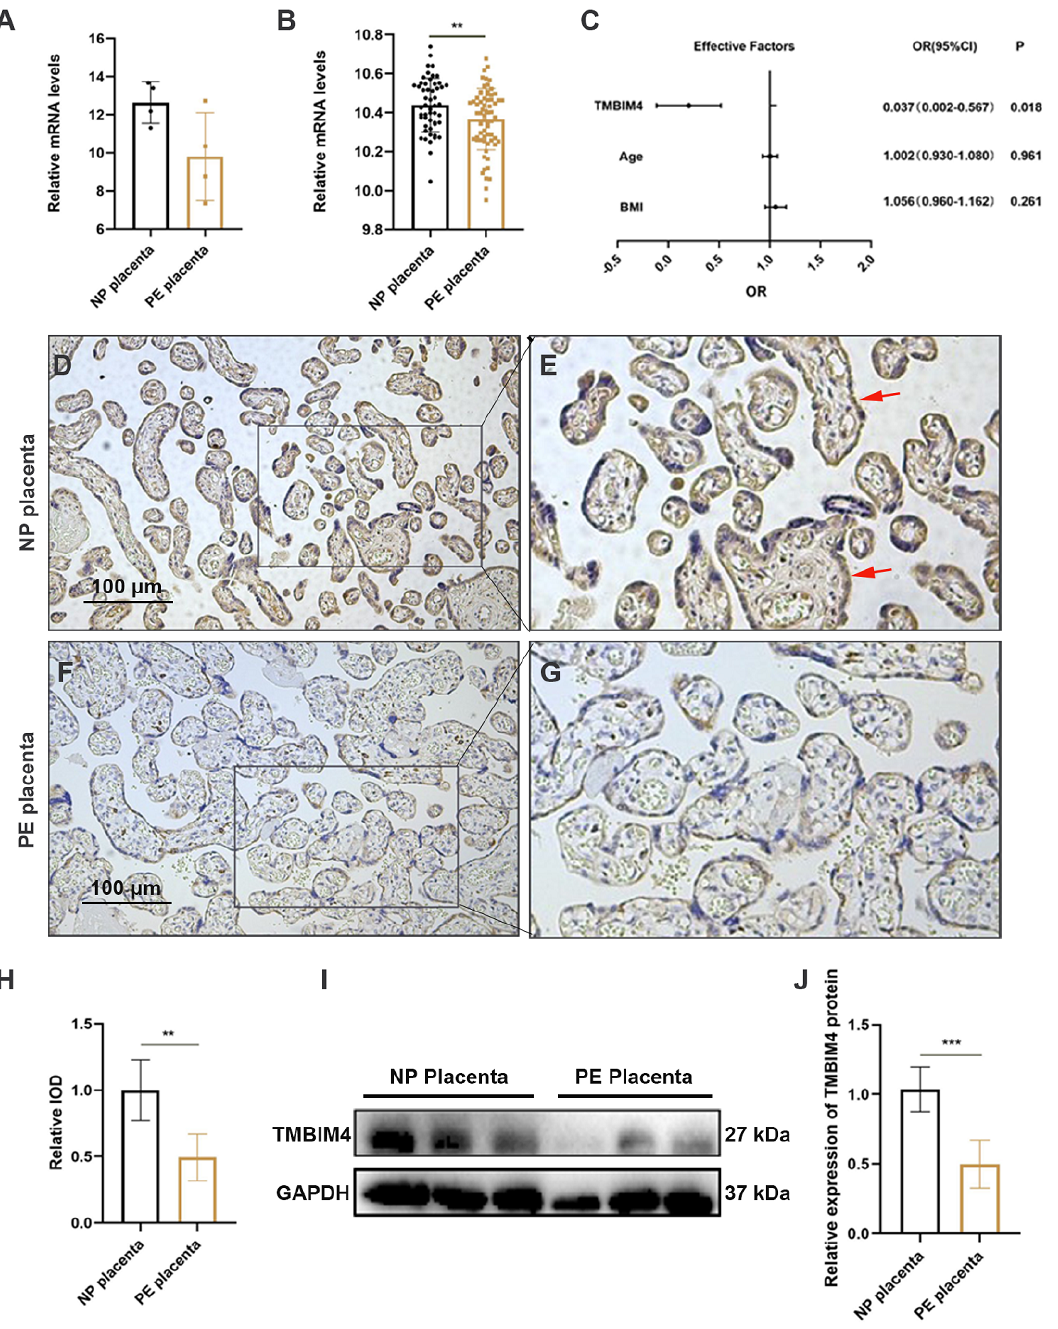
Figure 2. Decreased TMBIM4 levels in PE placentas. ( A ) Column plots showing normalized placental TMBIM4 mRNA expression from PE patients ( n = 4) and NP women ( n = 4) based on the analysis of the GEO dataset GSE147953. ( B ) Column plots showing the expression of TMBIM4 mRNA in PE ( n = 63) and NP ( n = 53) placentas. ( C ) Adjusted ORs with 95% CIs for the relationship between PE and TMBIM4 levels, which was adjusted for maternal age and BMI. ( D – H ) Representative immunohistochemical image showing TMBIM4 protein expression and localization in placentas from the NP and PE group ( n = 3 in each group, scale bars: 100 µ m). Red arrows refer to the positive signals on STBs. ( I , J ) The expression of placental TMBIM4 protein in NP and PE; graphs showing the results of quantitative densitometry analysis of TMBIM4. The results are presented as mean ± SD. * p < 0.05; ** p < 0.01; *** p < 0.001; Bar = 100 μm.